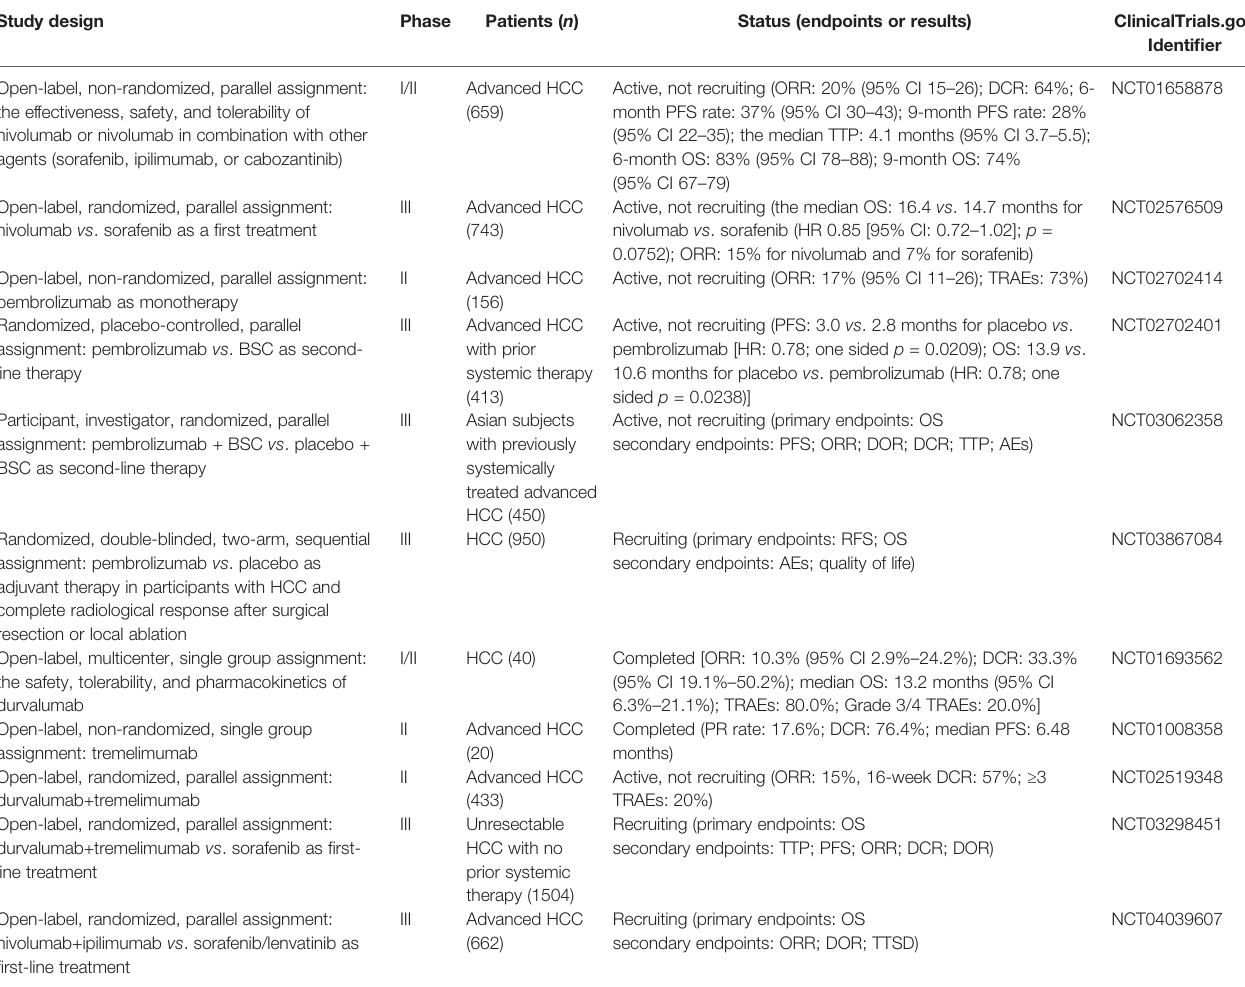
TABLE 1 | Clinical trials investigating the ef fi cacy of ICIs alone or multi-ICIs treatment in HCC. Study design Phase Patients ( n